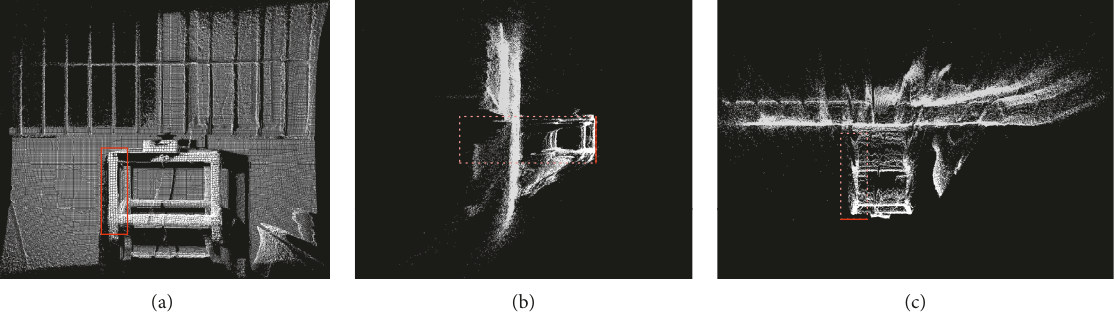
Figure 6: ROI for vibration measurement in the verification test, highlighted in red. 3D point cloud: (a) front view, (b) left view, and (c) top view.